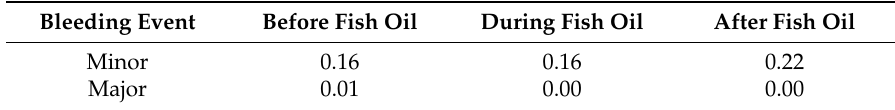
Table 3. Bleeding incidence per person ‐ year for patients before, during, and after supplementation.